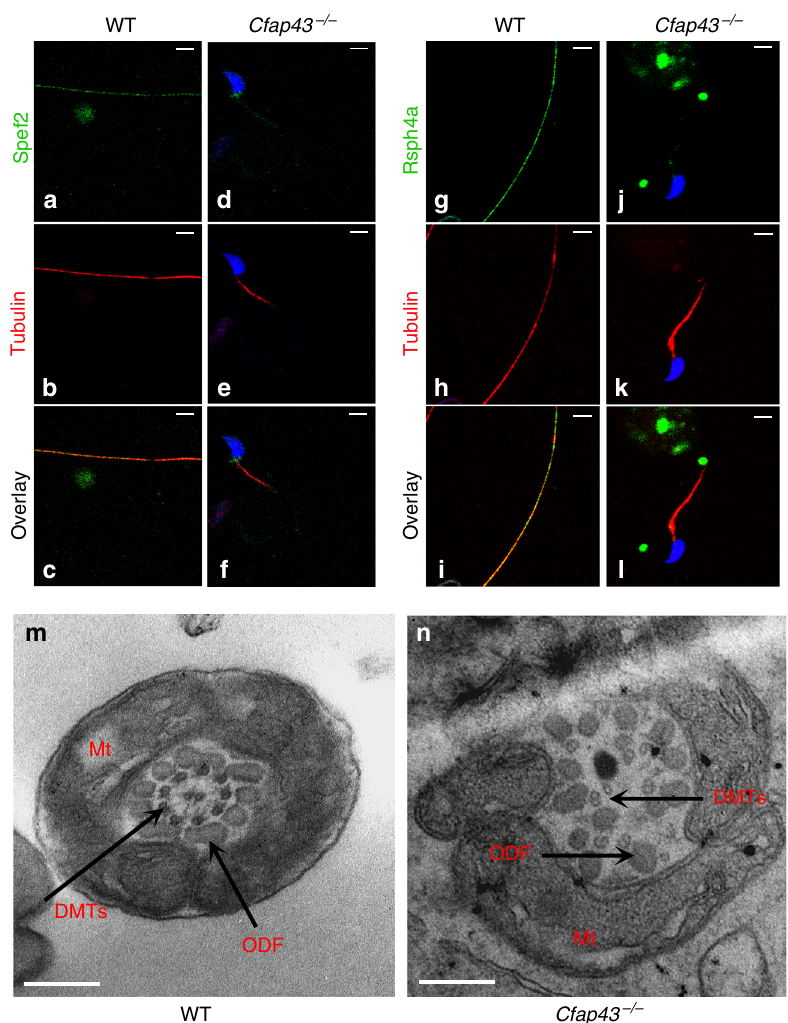
Fig. 5 The sperm axoneme from Cfap43 − / − males is fully disorganized. a Central pair is absent in sperm from Cfap43 − / − males. Staining of WT sperm with an anti-Spef2, a marker of the projection 1b of singlet C1 ( a , green) and anti-acetylated tubulin ( b , red) antibodies. c Overlay of Spef2 and tubulin staining. Sperms were counterstained with Hoechst (blue). d – f Similar experiments on sperm from Cfap43 − / − males. Scale bars = 5 µ m. g – l Head of radial spoke are absent in sperm from Cfap43 − / − males. Staining of WT sperm with an anti-Rsph4a, another protein of the RS head ( g , green) and anti-tubulin ( h , red) antibodies. i Overlay of Rsph4a and tubulin staining. Sperm were counterstained with Hoechst (blue). j – l Similar experiments on sperm from Cfap43 − / − males. Scale bars = 5 µ m. m , n Transversal section of a sperm from WT ( m ) and Cfap43 − / − ( n ) males observed by EM in the midpiece region. Note the speci fi c arrangement of the ODFs around the axoneme in WT sperm and the complete disorganization of the DMTs and the absence of the central pair in Cfap43 − / − sperm. Scale bars = 240 nm. Number of cross-section for WT and Cfap43 − / − were 21 and 30, respectively. All cross-section were defective for Cfap43 − / − . DMTs, doublet of microtubules; ODF, outer dense fi ber; Mt,